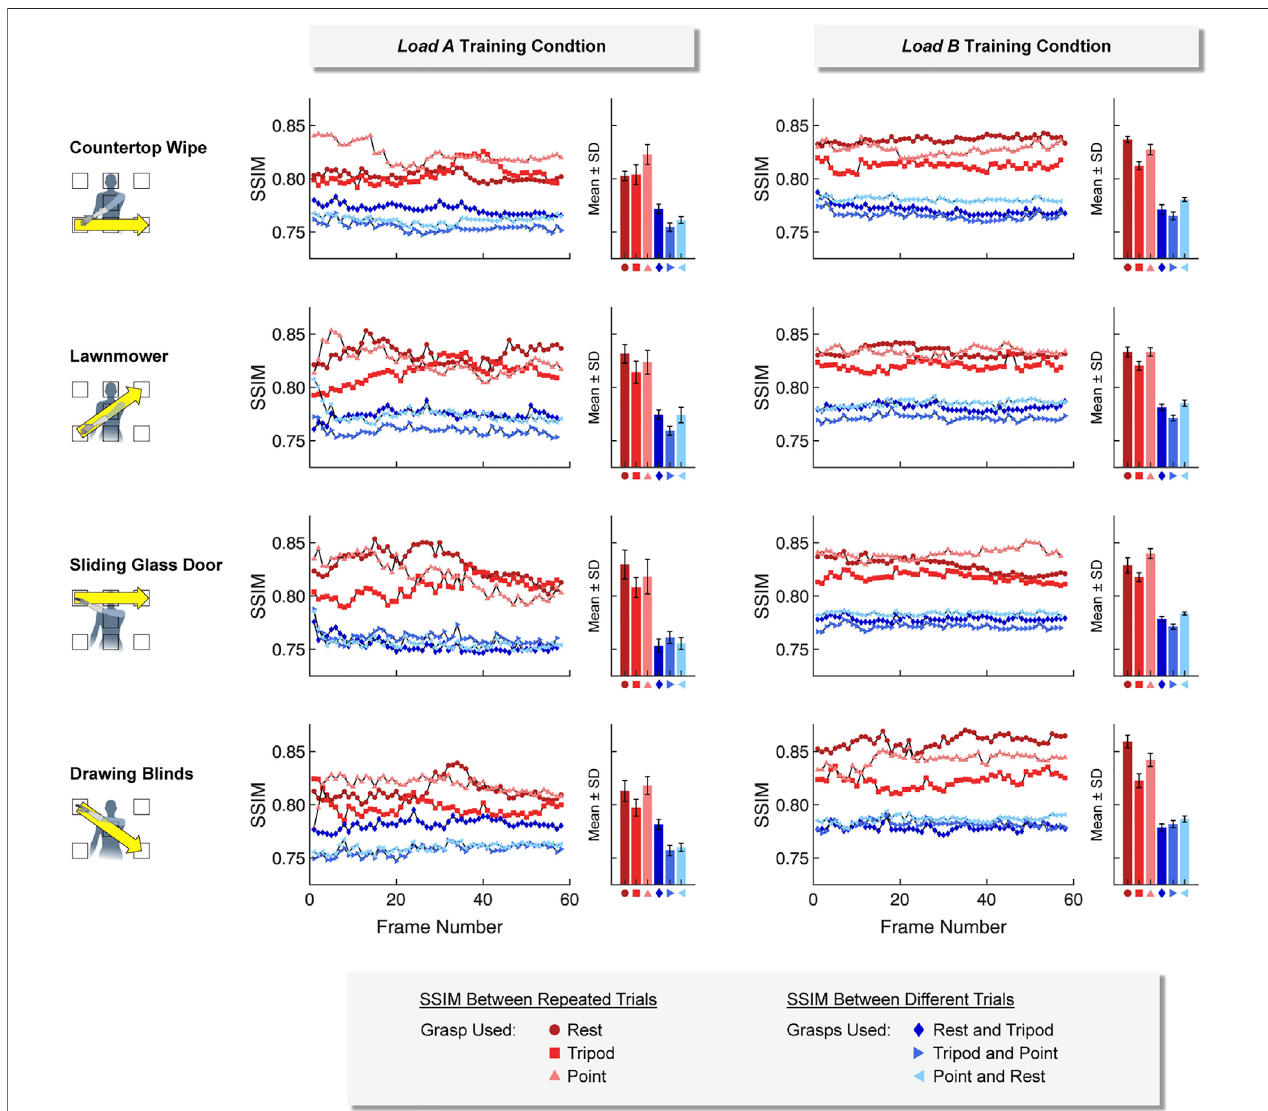
FIGURE8| Forthe dynamic trainingstrategy,wefoundthatultrasoundimagescollectedusingthesamehandgrasp(i.e.,repeatedtrials)weremoresimilartoeach otherthan ultrasound images collected using differenthand grasps (i.e., different trials). TheStructuralSimilarity Index (SSIM) wascalculatedfor each image frame ofthe respective 5-sec training